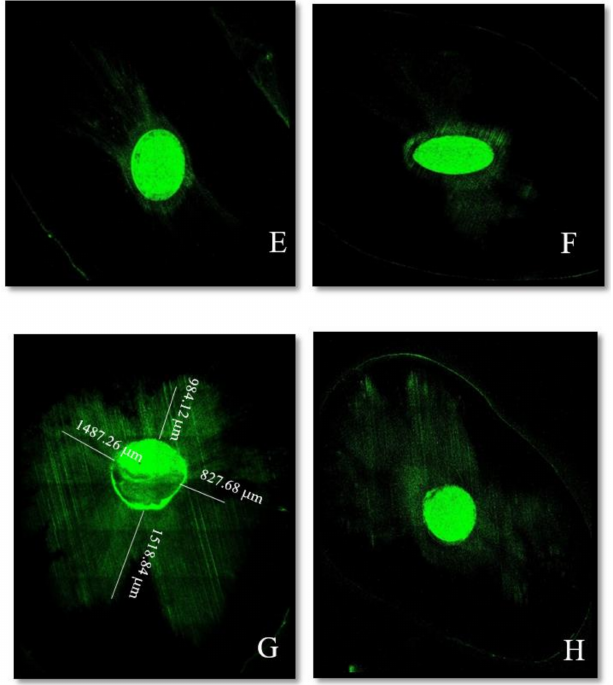
Figure 3. Representative confocal microscopic images of each sealer’s depth penetration in the dentinal tubules at 1 mm from the apex: ( E ) Bio-C sealer with the SC technique and ( F ) Bio-C sealer with WVC. Moreover, at 5 mm from the apex: ( G ) Bio-C sealer with the SC and ( H ) Bio-C sealer with